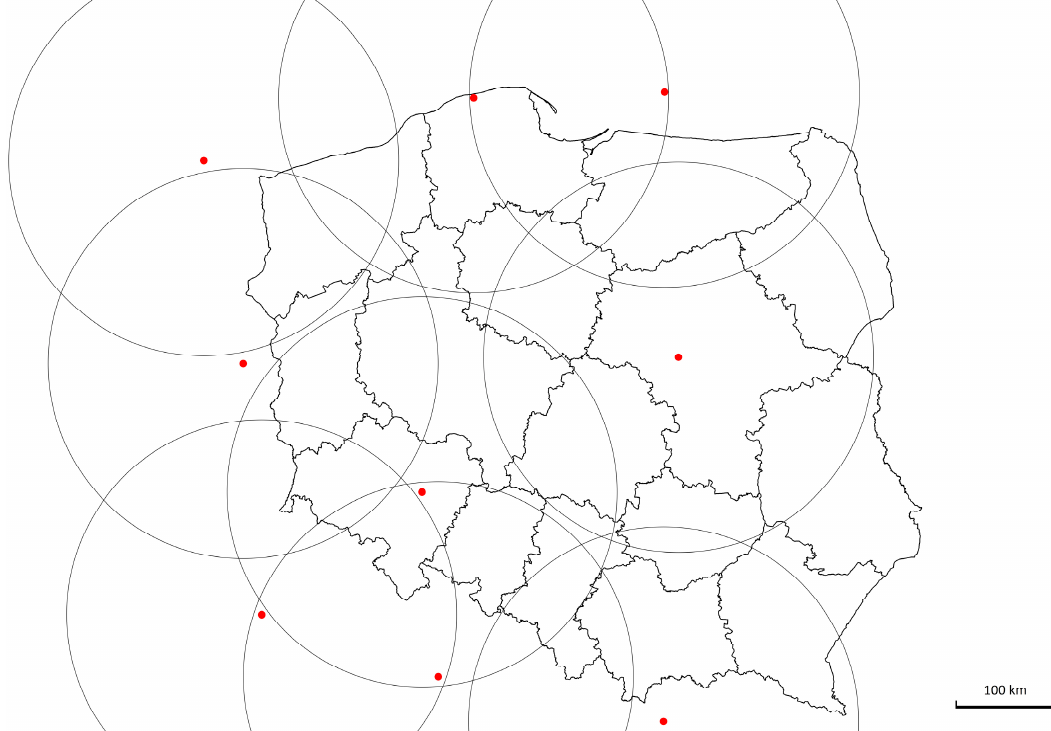
Figure 1. Contour map of Poland. The red dots represent the sounding stations location. The circles denote the area within 200 km from the sounding station.